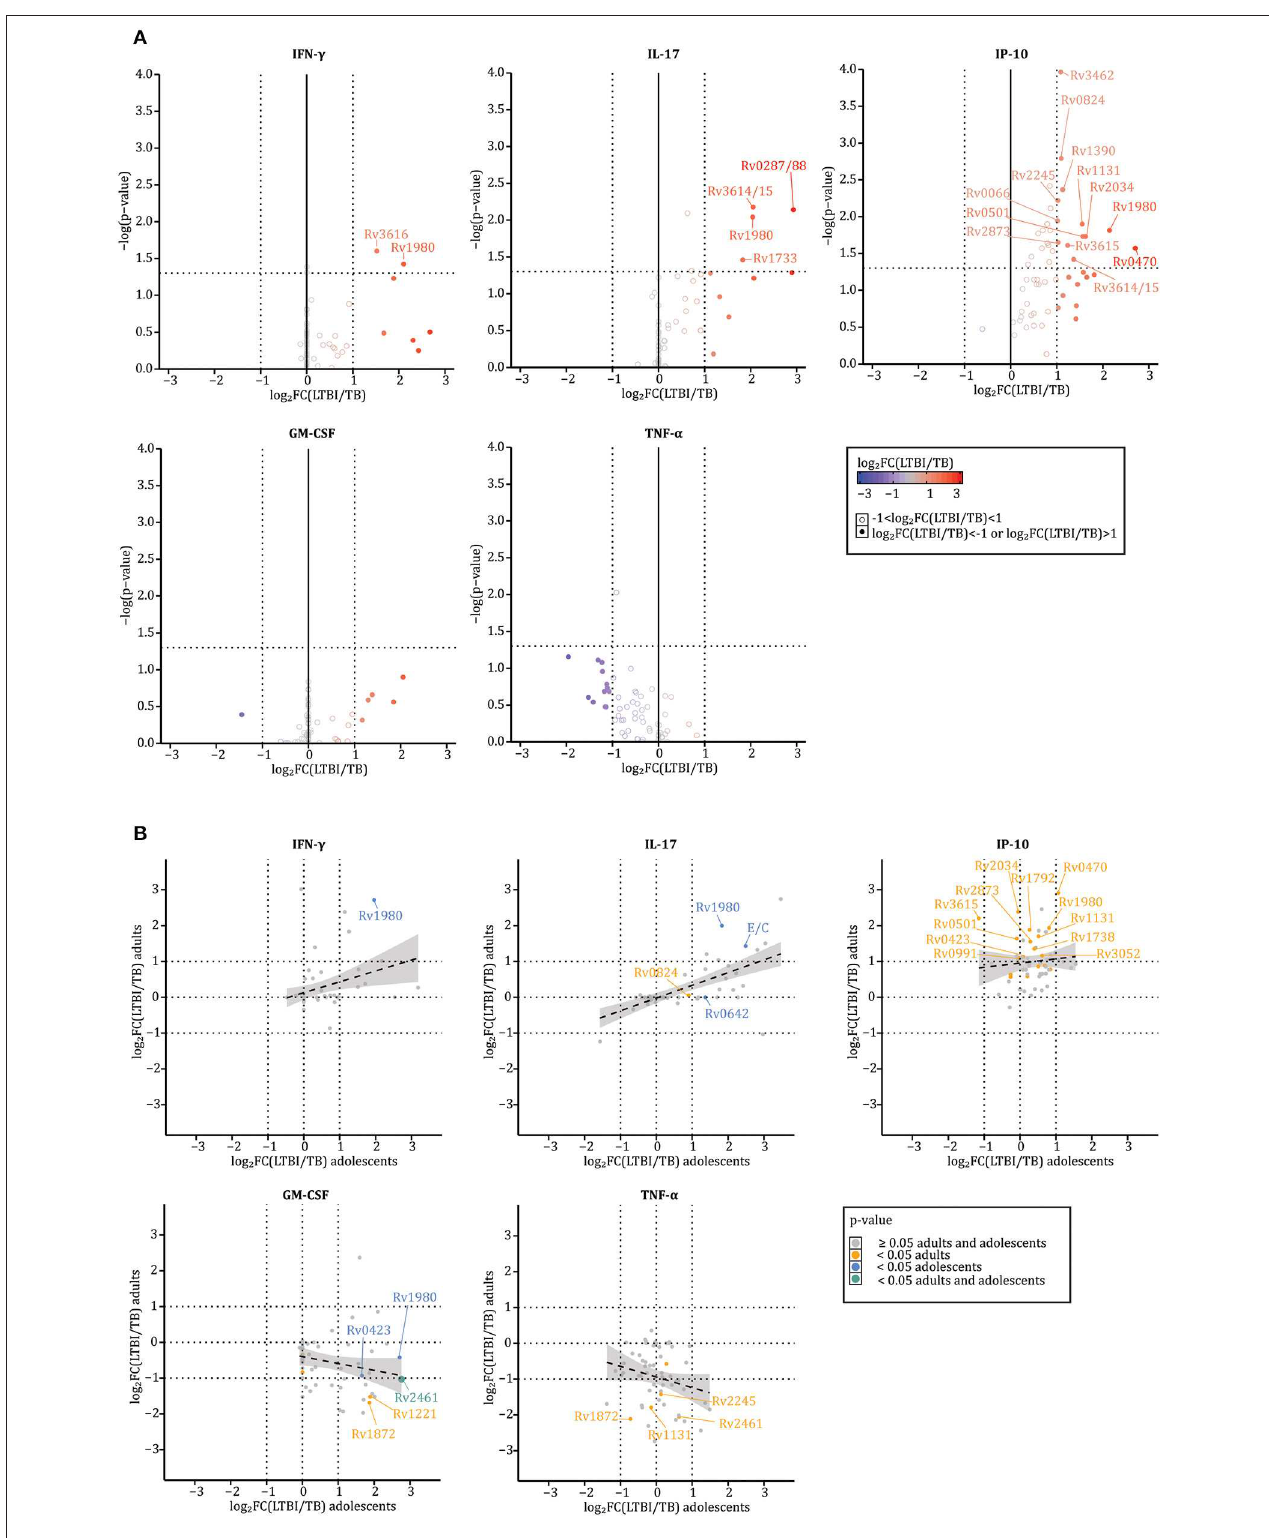
FIGURE 2 | LTBI individuals’ and TB patients’ blood cells secrete different amounts of cytokines in response to IVE-TB and stage specific Mtb antigens. The levels of nine cytokines were measured in diluted whole blood supernatants after 6 days stimulation with either IVE-TB, DosR, Rpf antigens (10 µ g/ml), ESAT6/CFP10